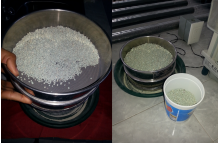
Figure A4. Treatment of natural zeolites (Clinoptilolite-Puebla and San Luis potosí, Heulandite-sonora).